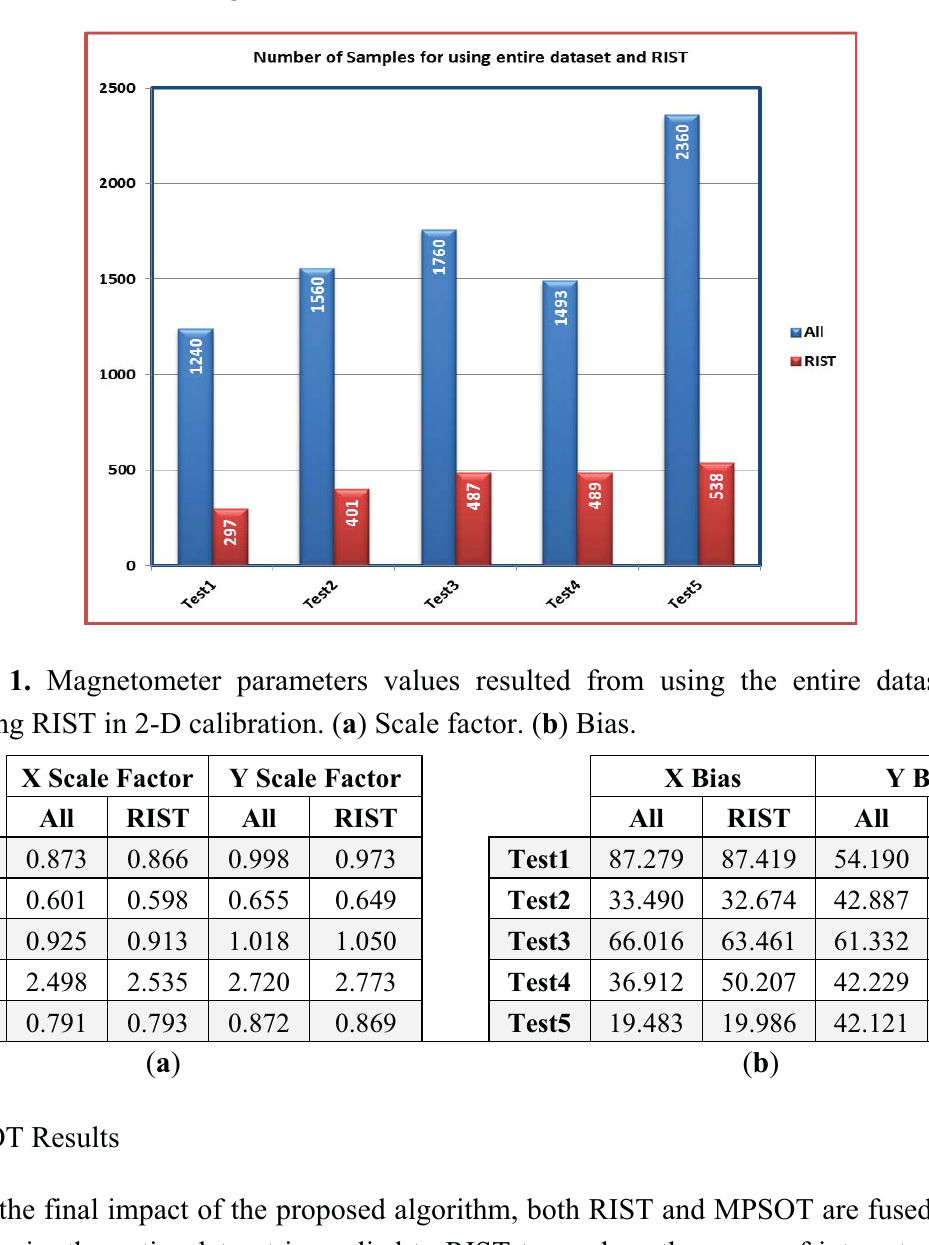
Figure 7. A comparison between the numbers of samples applied for magnetometer calibration in case of using the entire dataset and RIST in 2-D calibration.